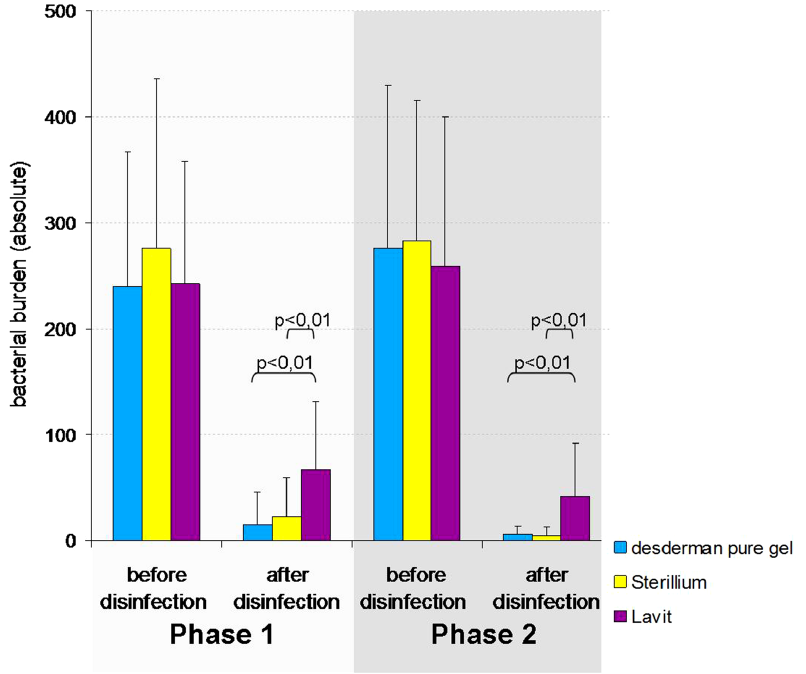
Figure 4. Bacterial burden in absolute numbers before and after disinfection (phase 1= without explanation of EN1500; phase 2= disinfection after explanation of EN1500). Standard deviation as indicated in the error bar.